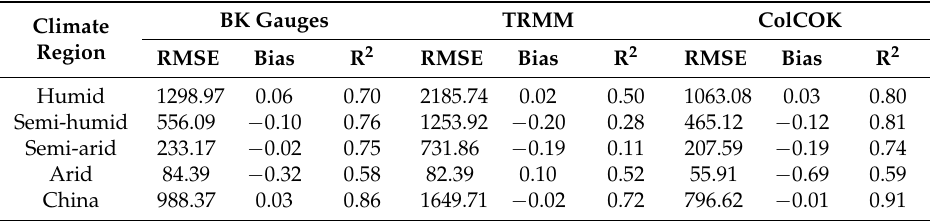
Figure 6. Scatter plot between the rain gauge calculated annual R factor and the estimated annual R factor from: ( a ) BK gauges, ( b ) TRMM, and ( c ) ColCOK, based on the 217 testing data set for 2002– 2013. Table 3. Overall performance of validation results of the BK gauge-, TRMM-, and ColOCK-based yearly rainfall erosivity estimates in comparison with the 217 testing rain gauges Climate Region